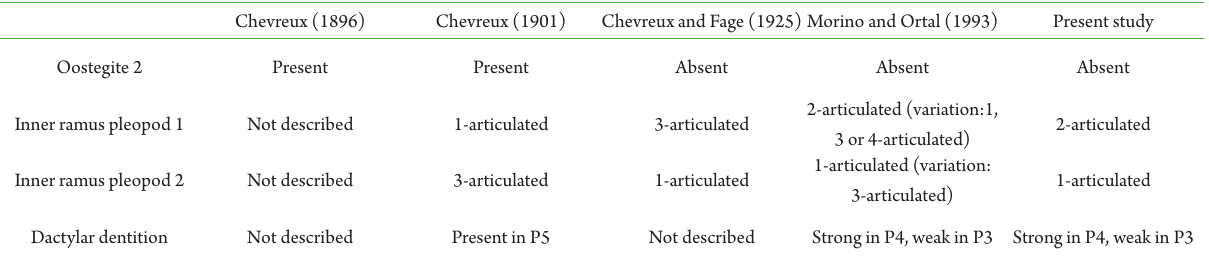
Table 1. Literature descriptions of Talitroides alluaudi (Chevreux, 1896) among early and more recent studies. P =